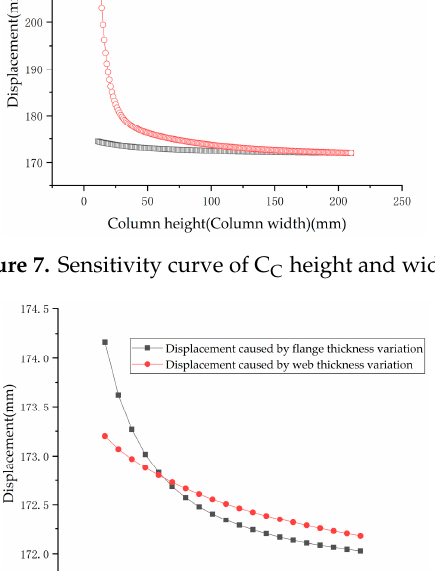
8 of 15 Figure 4. Sensitivity curve of B S plate thickness. Figure 5. Sensitivity curve of B M height and width.